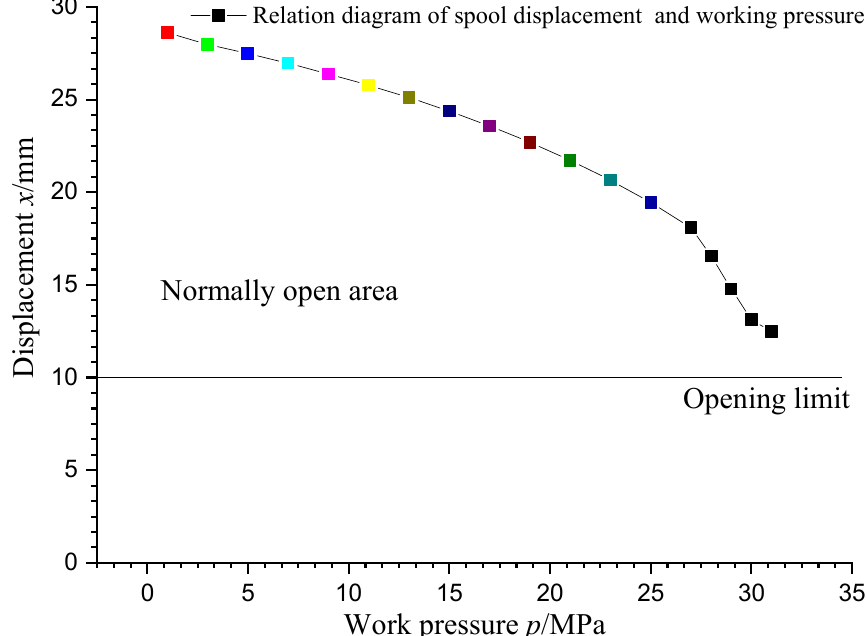
Figure 10. Relationship between working pressure and valve opening of the differential valve.